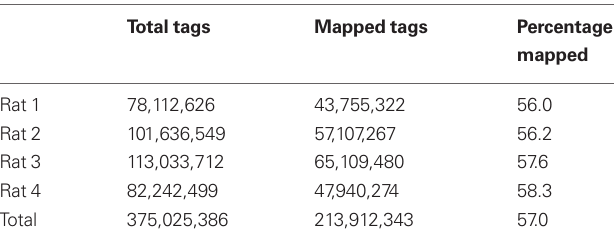
Table 1 | Genome mapping. Total tags Mapped